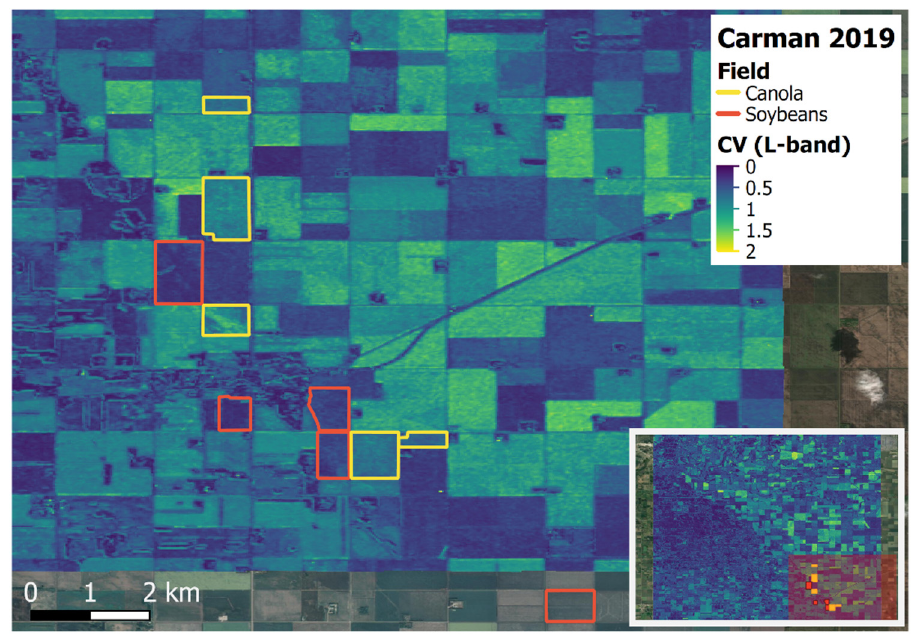
Figure 9. Biomass fields within the study area. Table 6. Field data for wet biomass (time-averaged) and the coefficient of variation